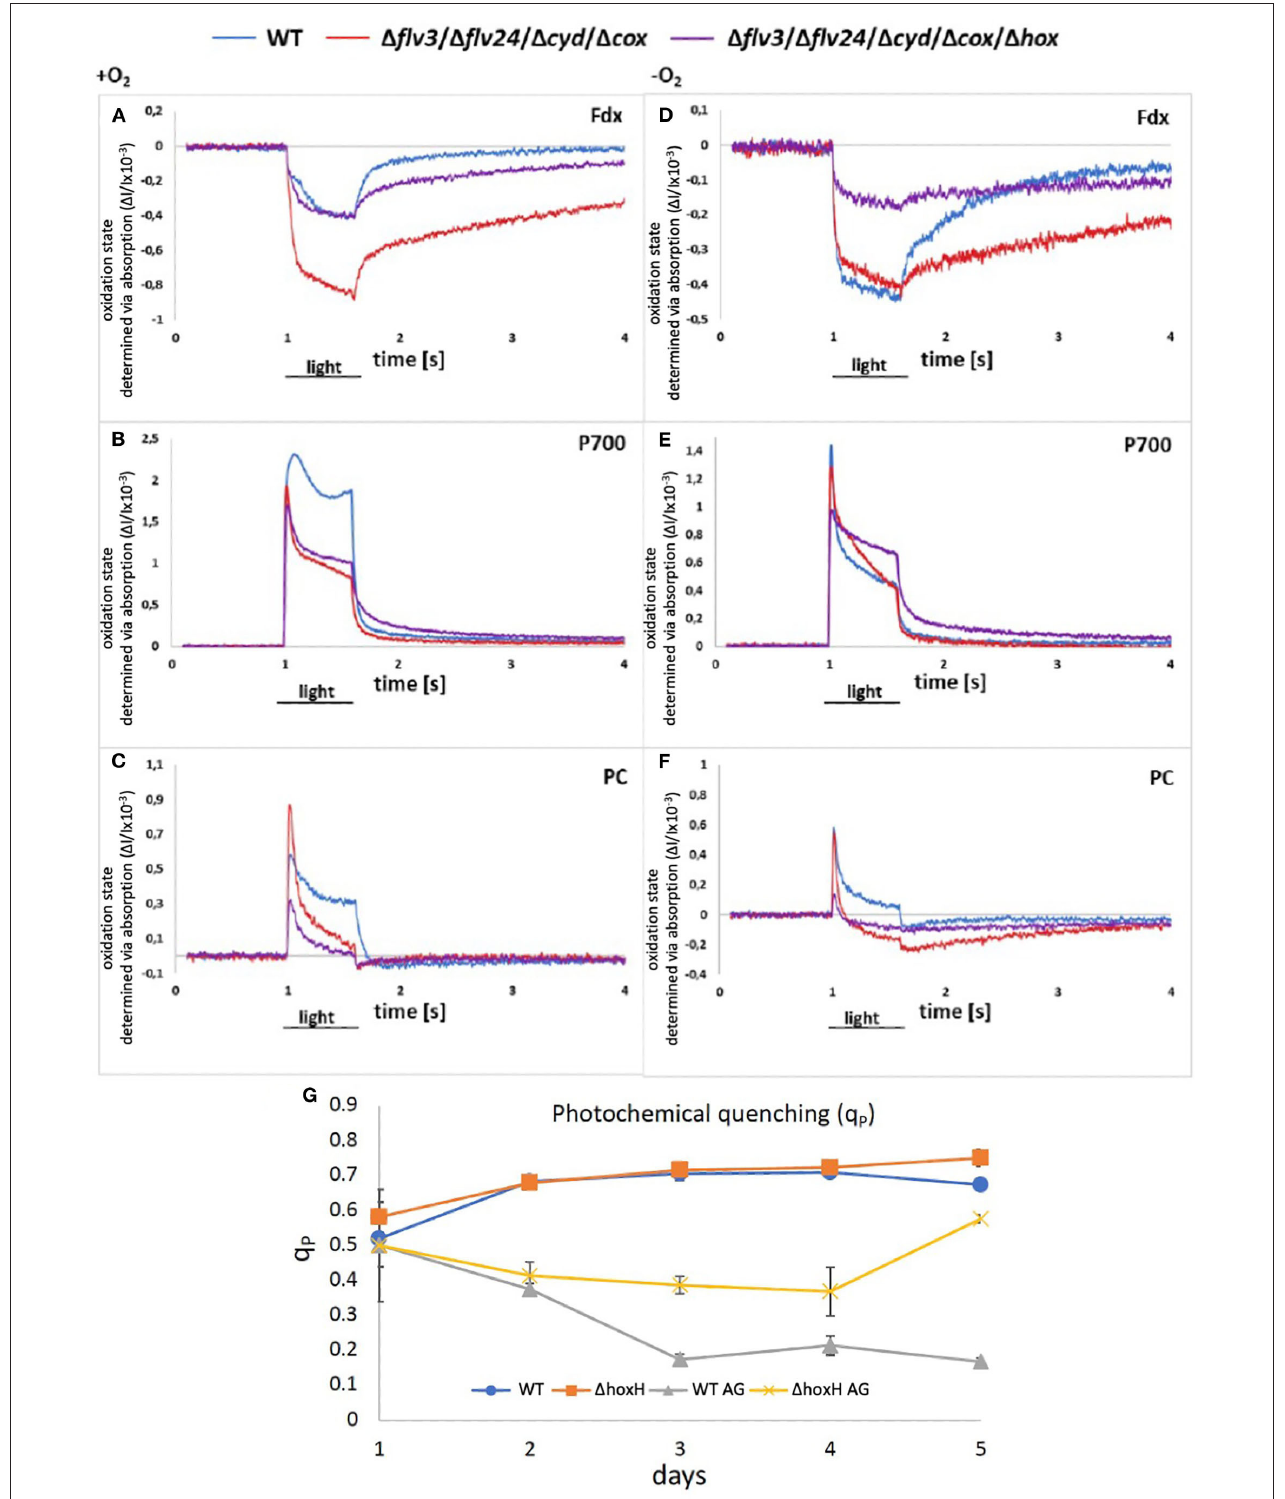
FIGURE 7 | (A–F) Redox states of components of the photosynthetic electron chain on arginine and glucose in the presence and absence of oxygen in WT, 1 flv24 1 flv3 1 cox 1 cyd, and 1 flv24 1 flv3 1 cox 1 cyd 1 hox. The oxidation state was measured as absorption change ( 1 I/I × 10 − 3 ). Positive values show oxidation and negative values show a reduction of components. (G) Photochemical quenching (q P ) in WT and 1 hoxH on nitrate (WT and 1 hoxH ) and on arginine and glucose (WT AG and 1 hoxH AG).